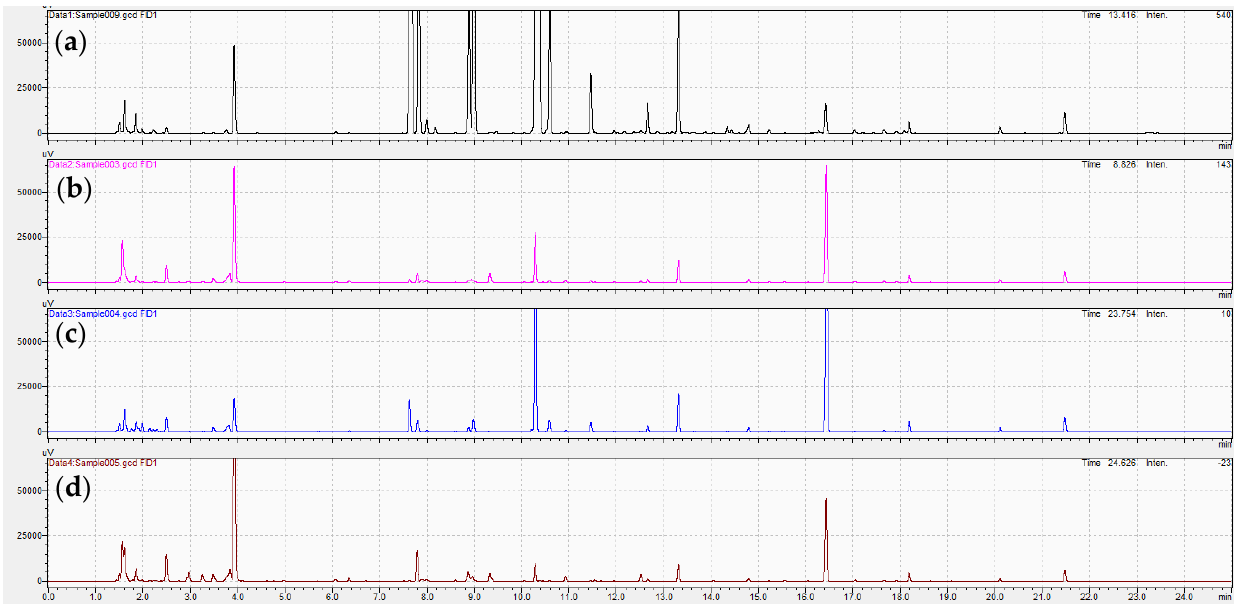
Figure 3. The GC chromatograms of black cumin seed oils obtained from ( a ) screw press machine and SCCO 2 extractions at 20.0 MPa, ( b ) 40 °C, ( c ) 50 °C, and ( d ) 60 °C. The y-axis is normalized to the similar maximum intensity of 7.5 × 10 4 µV.